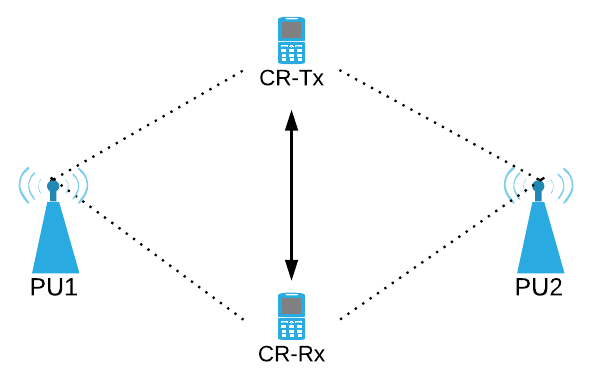
Table 2. Successful